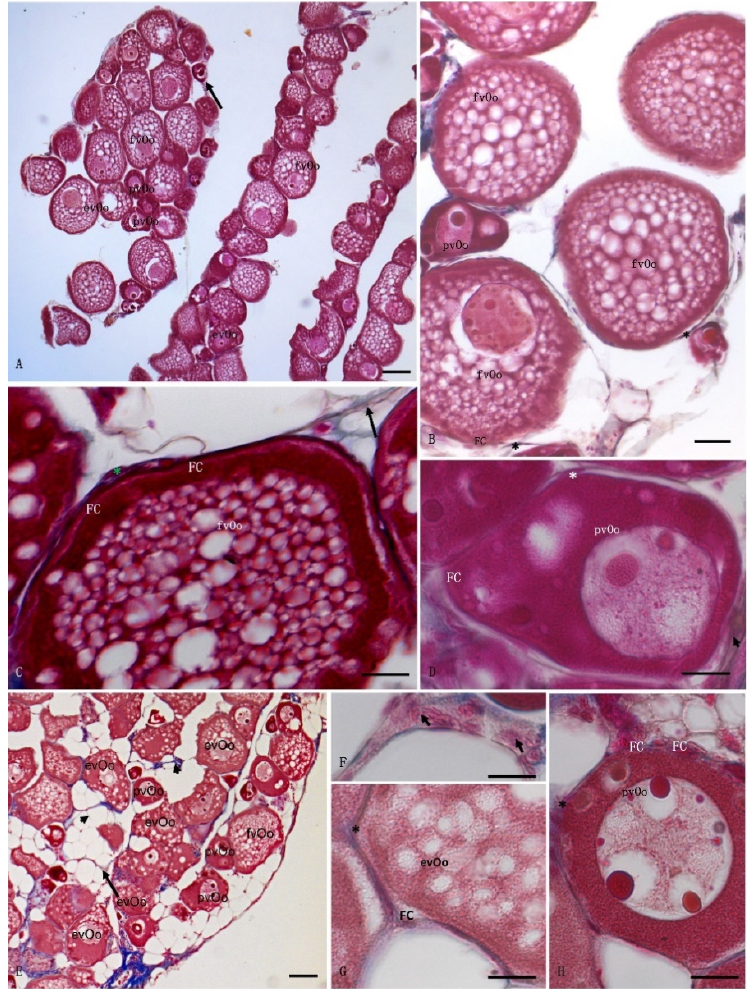
Figure 1. Light micrographs of Anguilla anguilla ovaries. Mallory staining. ( A – D ) control specimens. The ovary showed numerous fully vitellogenic oocytes (fvOos) and early vitellogenic oocytes (evOos), along with few previtellogenic oocytes (pvOos) and connective interfollicular cells (arrowheads). ( E – H ) Exposed specimens, containing more connective tissue (arrows) and previtellogenic oocytes (pvOos) than the control specimens. FC, follicular cells; asterisk, theca cells. Scale bars: ( A , E ) = 100 µm; ( B ) = 50 µm; ( C , D , F – H ) = 5 µm.